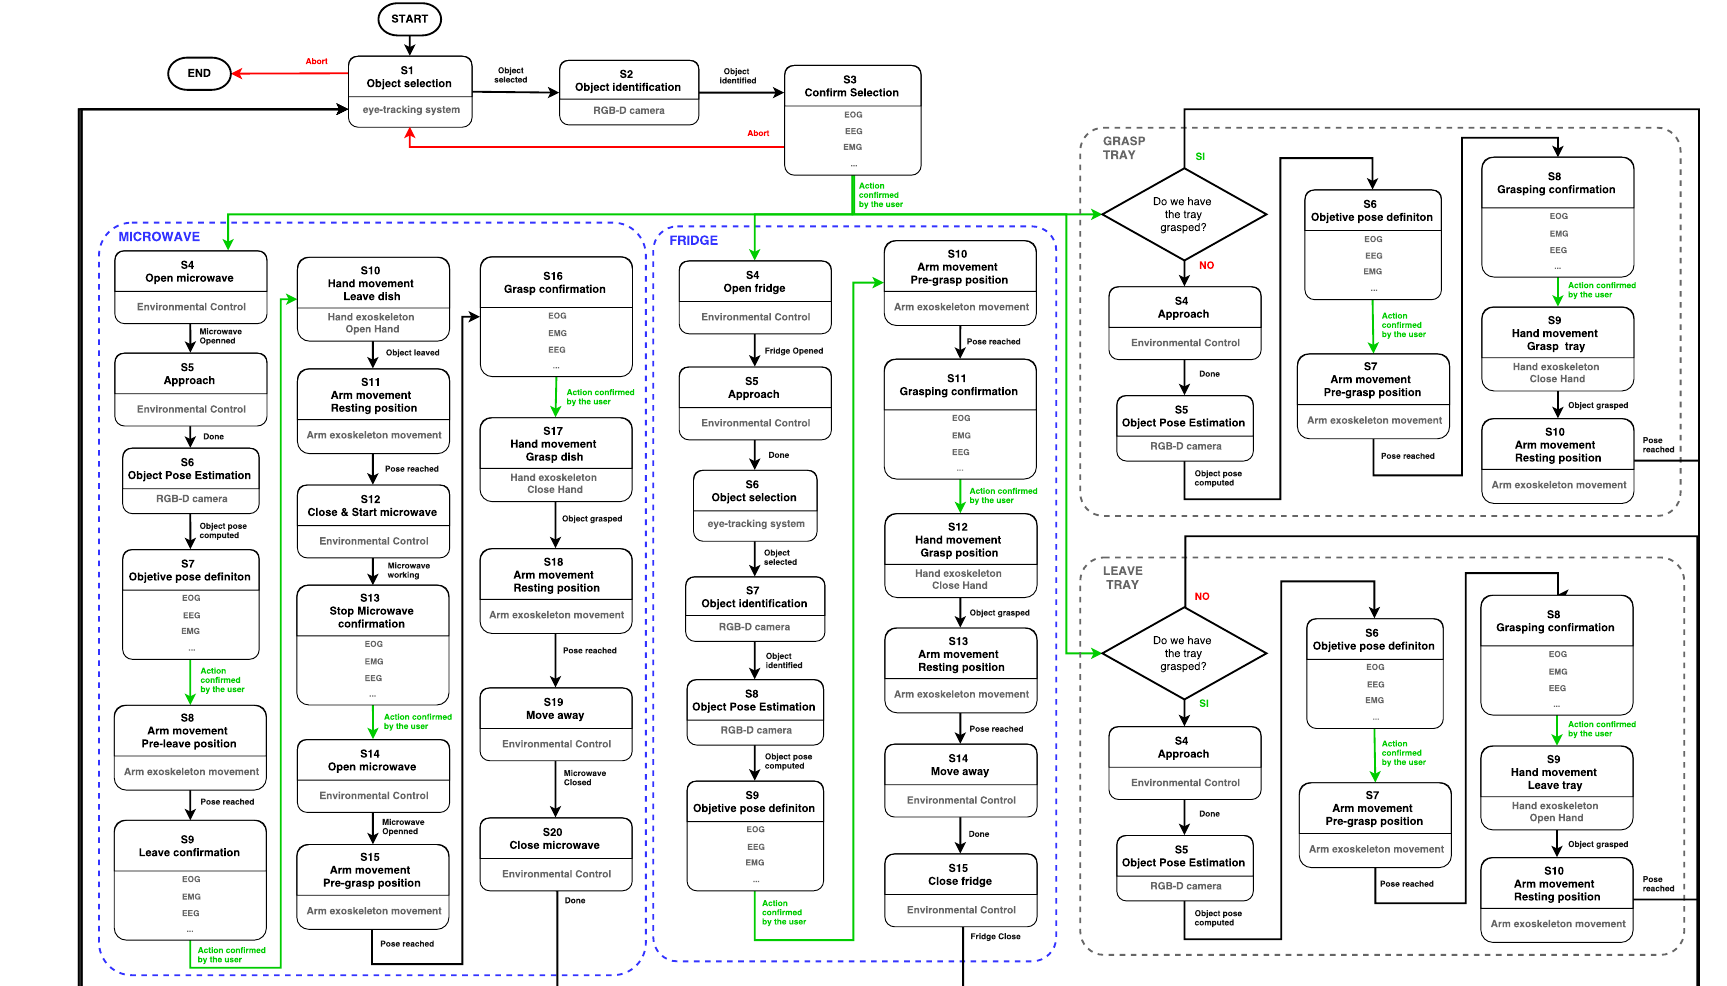
Figure 6. FSM for preparing a meal. The states are sequentially implemented, allowing the user to continue or abort the task at anytime. Black arrows refer to automatic processes. Green arrows refer to an action confirmed by the user, and red arrows refer to the decision to abort the current activity by the